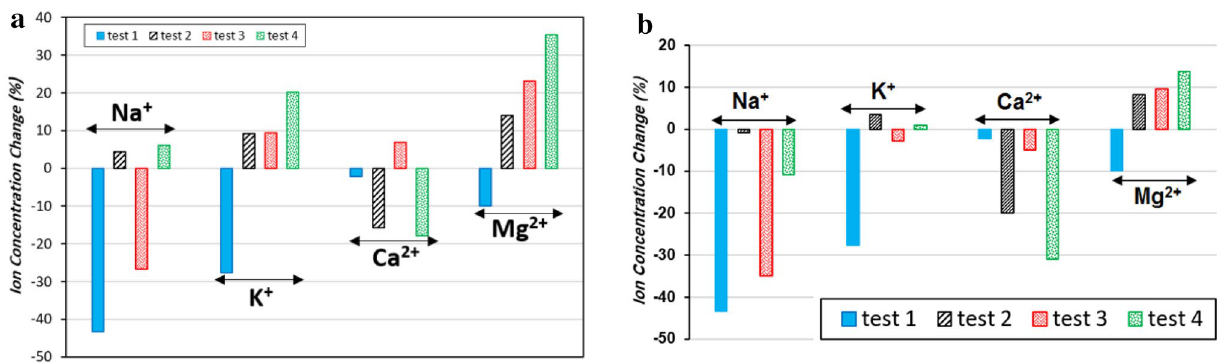
Fig. 9 Percentage of ion concentration change for test 1–4. Left pic- ture ( a ) is the percentage of ion concentration change and right pic- ture ( b ) shows the percentage of ion concentration change in com-